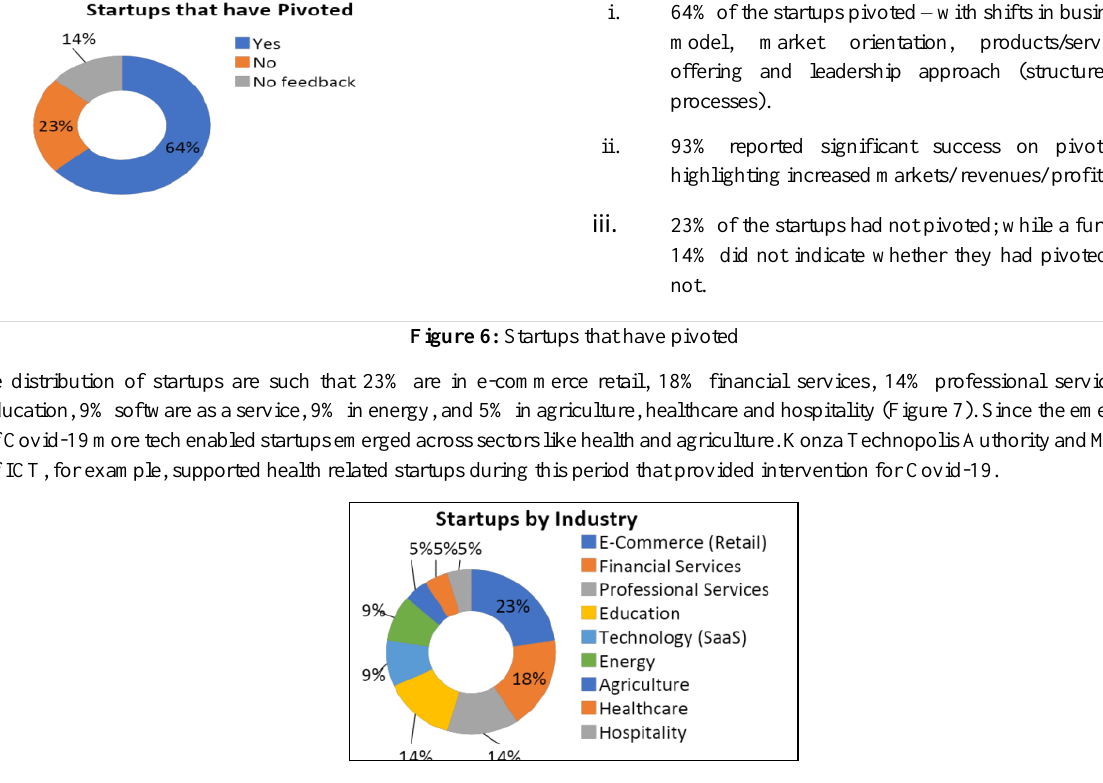
Figure 7: Startup by Industry in Kenya